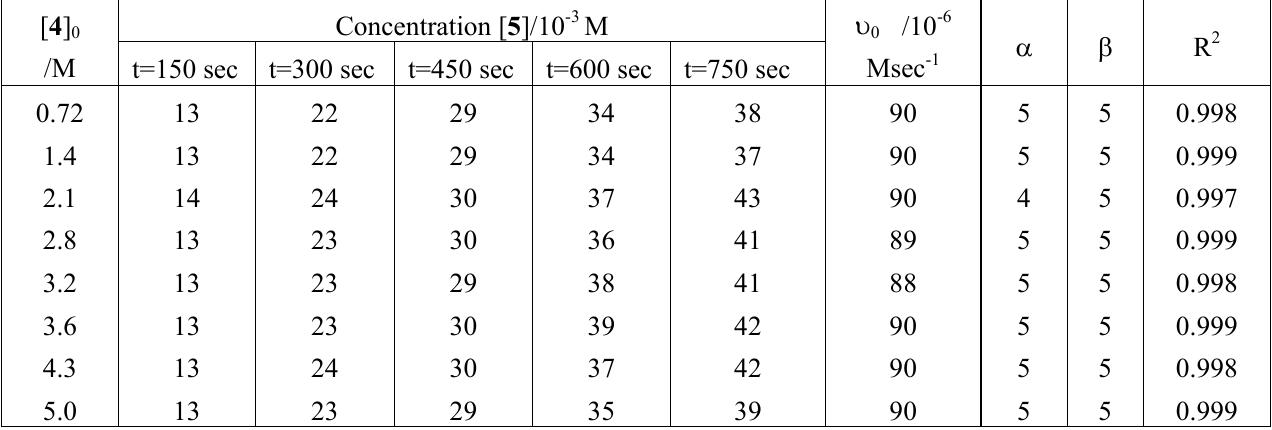
Table 2 . Kinetic data for obtaining the reaction-order of 4 in the reactions of 1 (0.17 M) with thioanisole ( 4 ) using a mixture (16.0 mL) of 4 and CH (8.0 mL) at 10 °